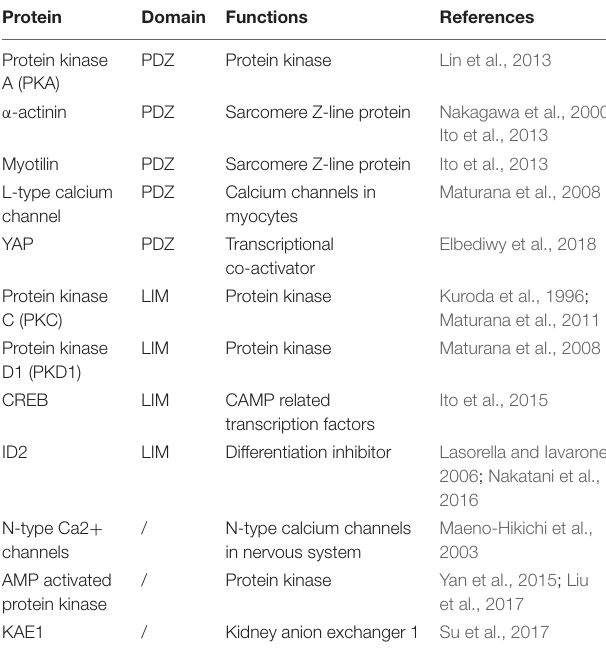
TABLE 1 | Binding partners of PDLIM5 and their